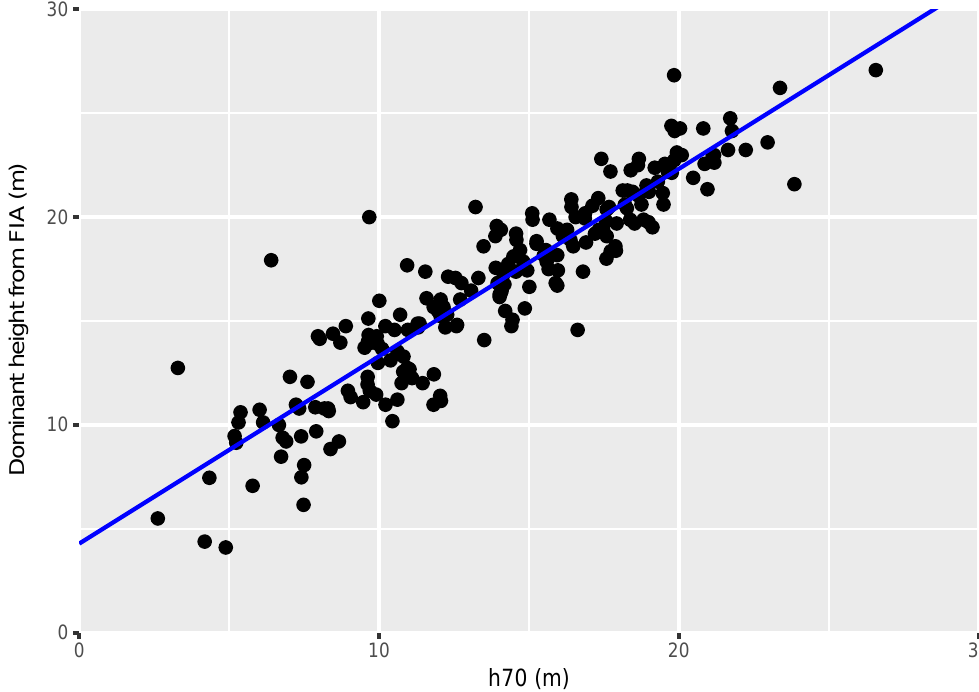
Figure 6. Scatterplot showing the plot-level agreement between the 70th percentile of ALS first return heights and the FIA-measured average dominant tree height ( n = 211 plots). The fitted linear model is indicated by the blue